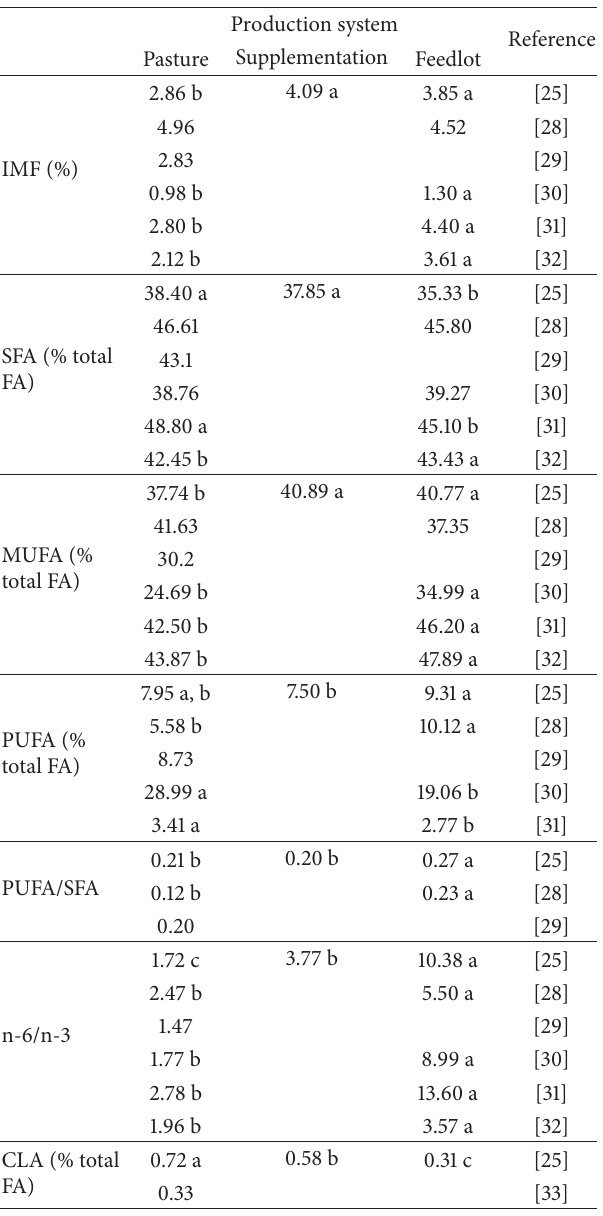
Table 1: Lipid content and fatty acid composition reported of beef muscle from steers (British and crossbred) finished in different and contrasting production